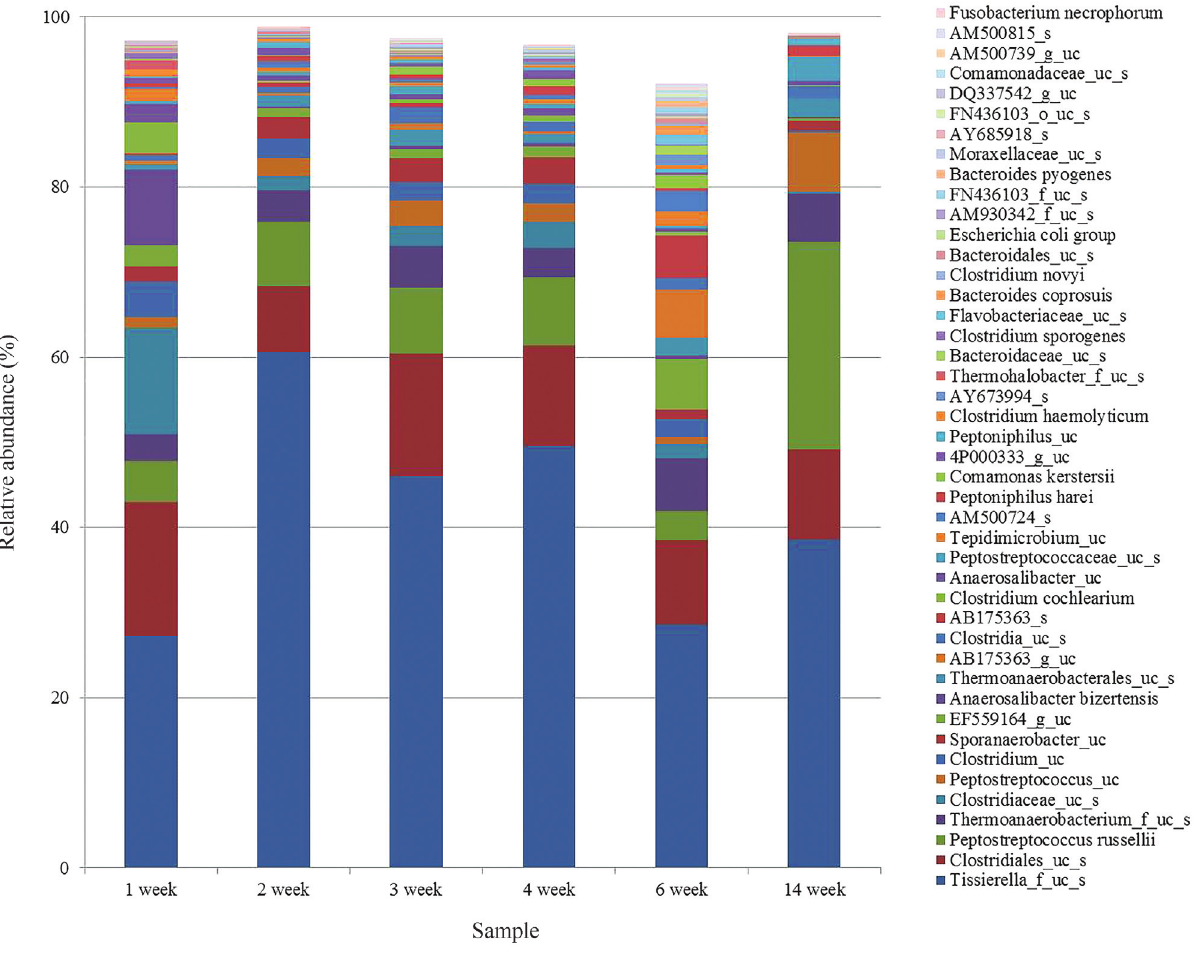
Figure 4 - Comparison of the species compositions of bacterial communities during each period. The names of species are based on the EzTaxon-e data-